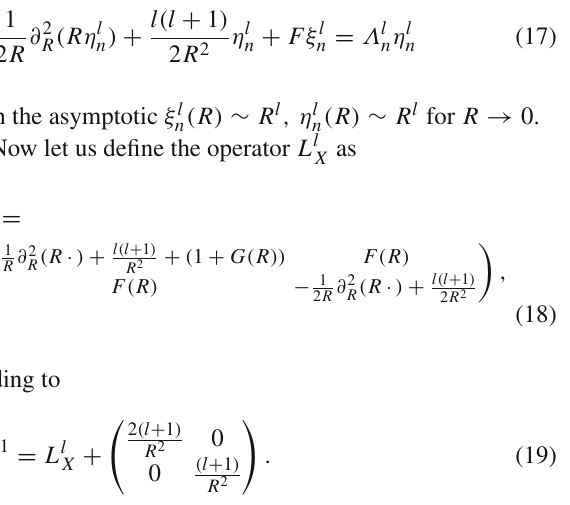
with the asymptotic ξ l